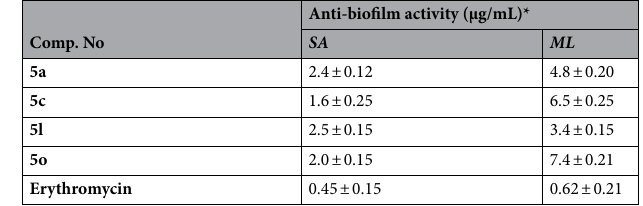
Table 3. Anti-biofilm activity (IC 50 , μg/mL) of compounds 5a , 5c , 5l , 5o and the broad-spectrum antibiotic Erythromycin against Staphylococcus aureus IFO 3060 ( SA ) and Micrococcus luteus IFO 3232 ( ML ). *Results are the mean values of three experiments ± SD.